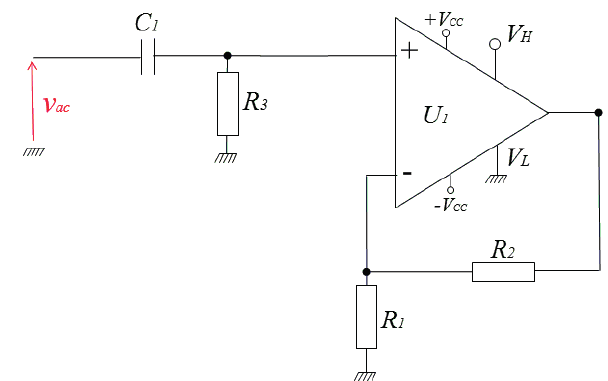
Figure 2. The electronic circuitry of the half wave rectifier. U 1 : OPA699, C 1 = 100 nF, R 3 = 50 Ω ( impedance matching), R 1 = 150 Ω , R 2 = 750 Ω